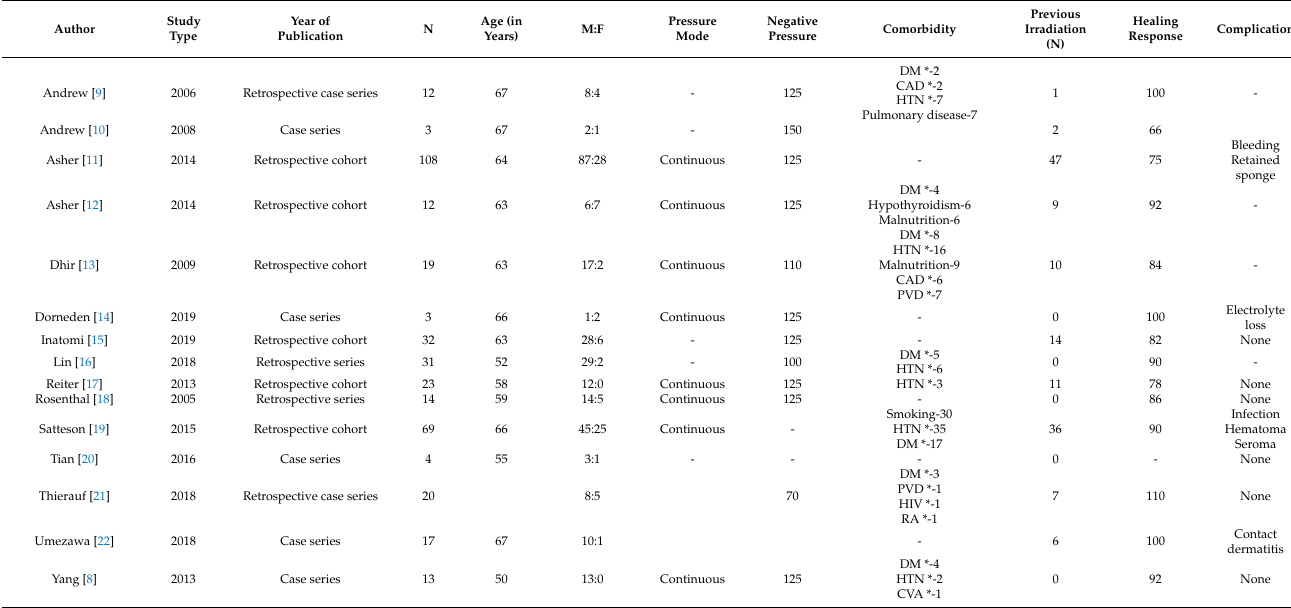
Table 1. Demographics of the cohort, wound response, healing time, pressure dynamics, comorbidities, risk factors, and